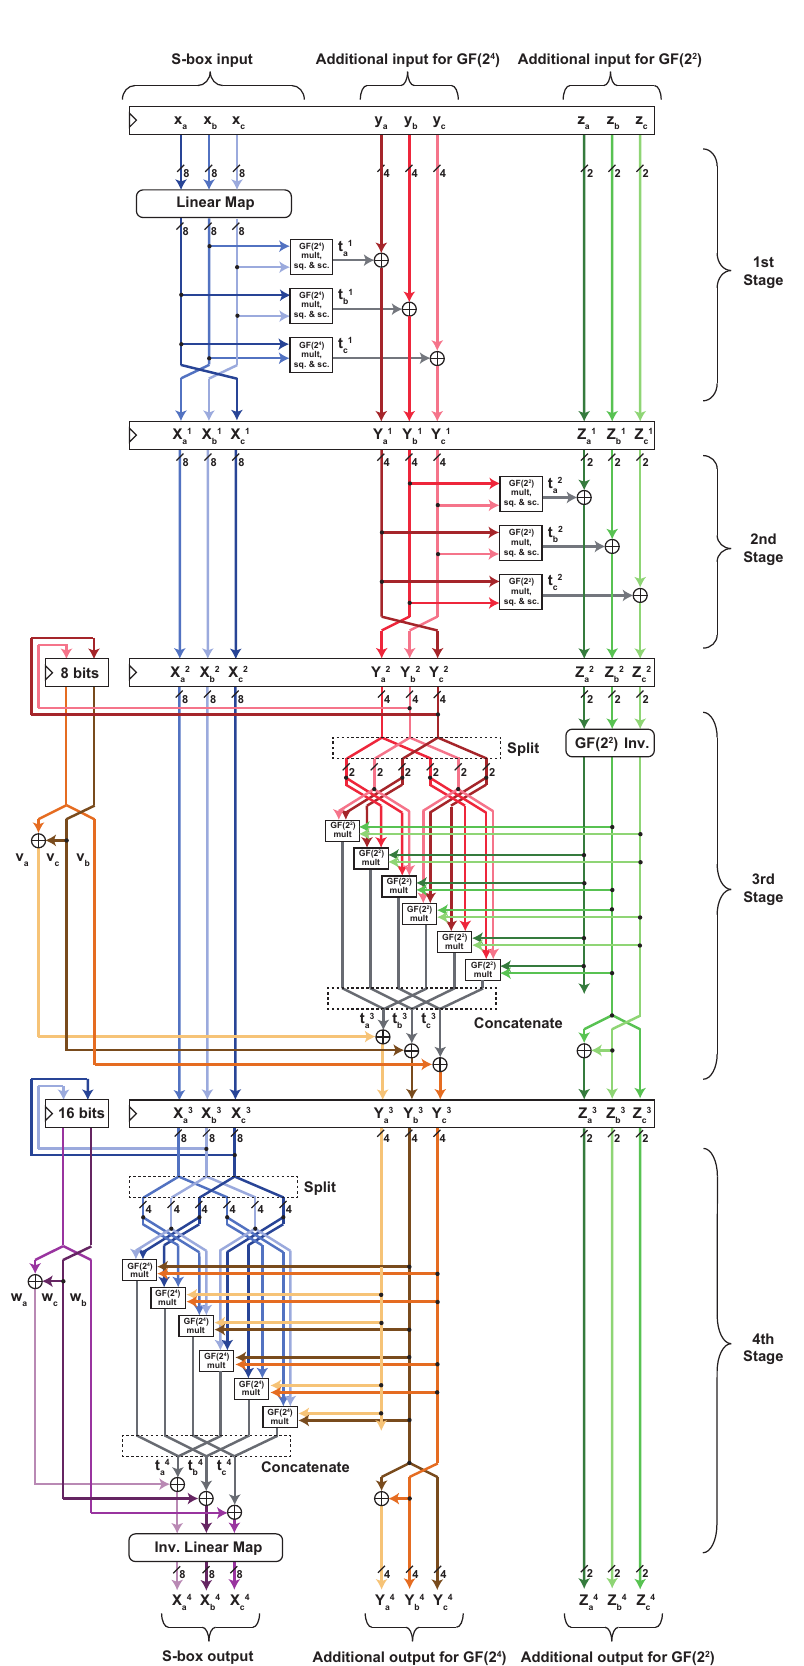
Figure 8: Proposed 3-share TI of the AES S-box. Edges are colored based on Table